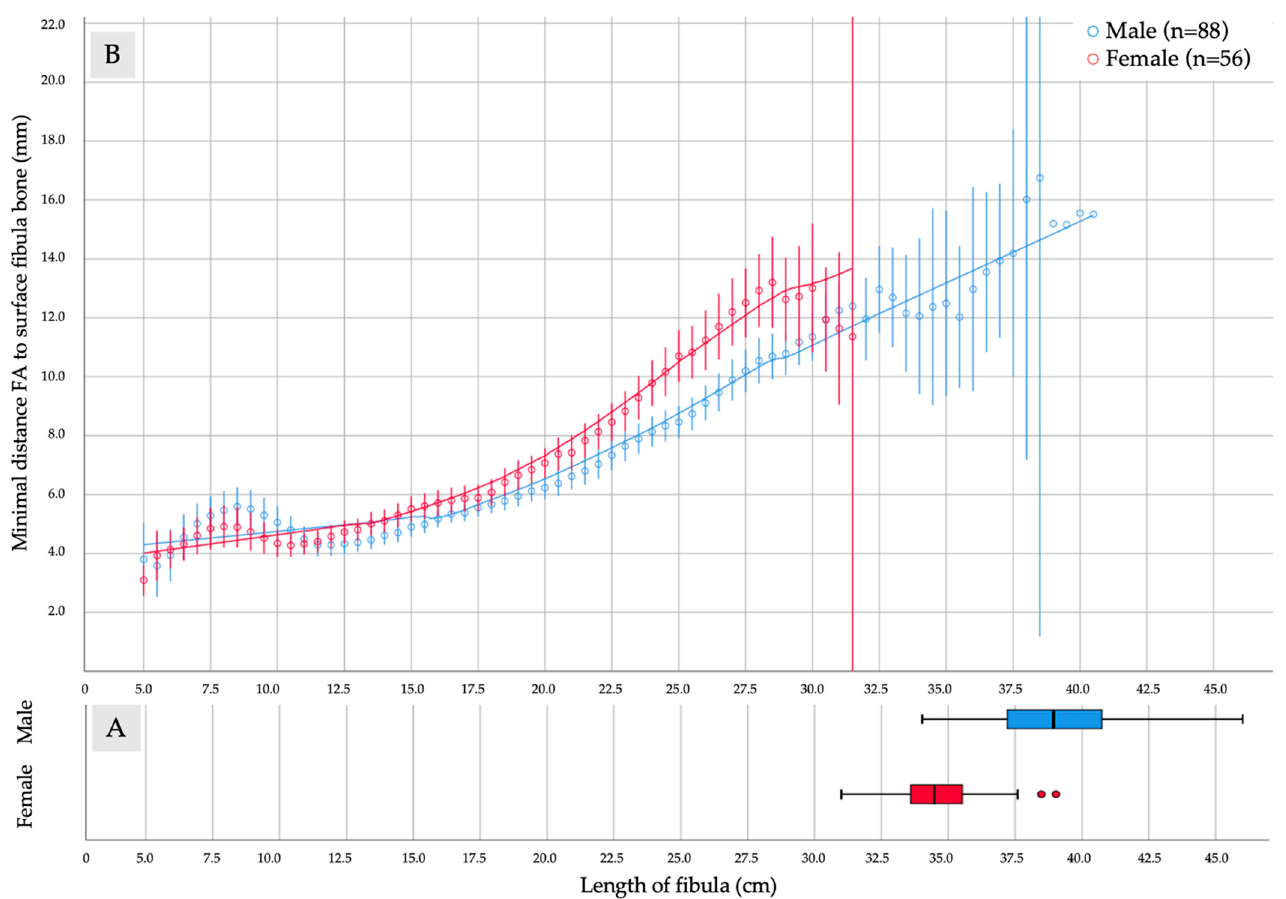
Figure 3. The diagram summarizes assessed parameters of ( A ) length of fibula and ( B ) distance and length of the fibular artery (FA) in relation to fibular bone surface in CTA of 144 lower limbs in 72 patients. ( A ) A significant difference for total length of the fibular bone was measured (male: n = 88, mean ± SD: 39.08 ± 2.35 cm vs. female: n = 56, mean ± SD: 34.60 ± 1.70 cm; p = 0.0001). ( B ) Comparison of the minimal distance of FA run-off (mm) in males ( n = 88) and females ( n = 56) measured in axial planes from the distal tip of the fibula (cm). LOESS curves with the inclusion of 50% of the assessed points were drawn.